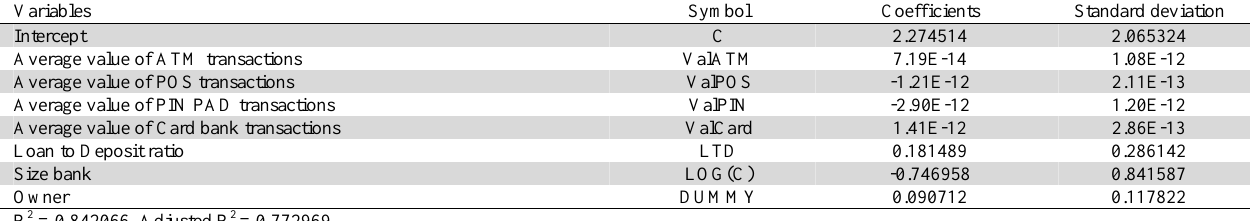
The relationship between the development of e-banking and INATINL